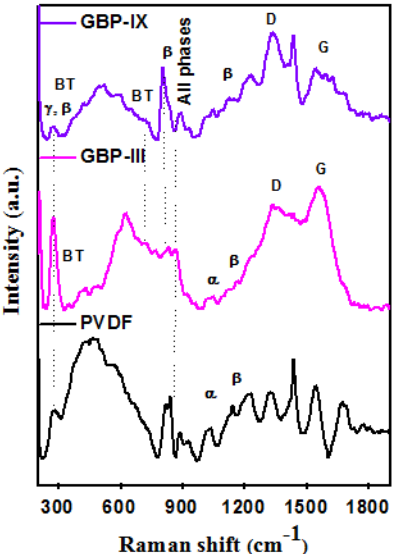
Figure 4. Raman spectra of PVDF, GBP-III, and GBP-IX nanocomposite films.